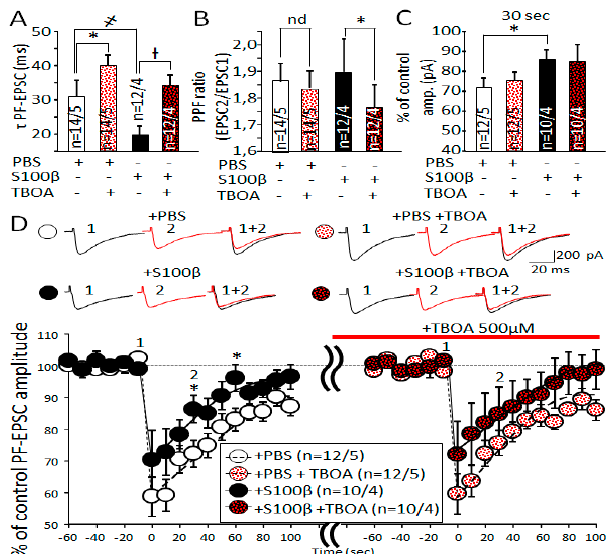
Figure 9. Inhibition of glutamate uptake by TBOA alters PF-EPSC kinetic, but does not a ff